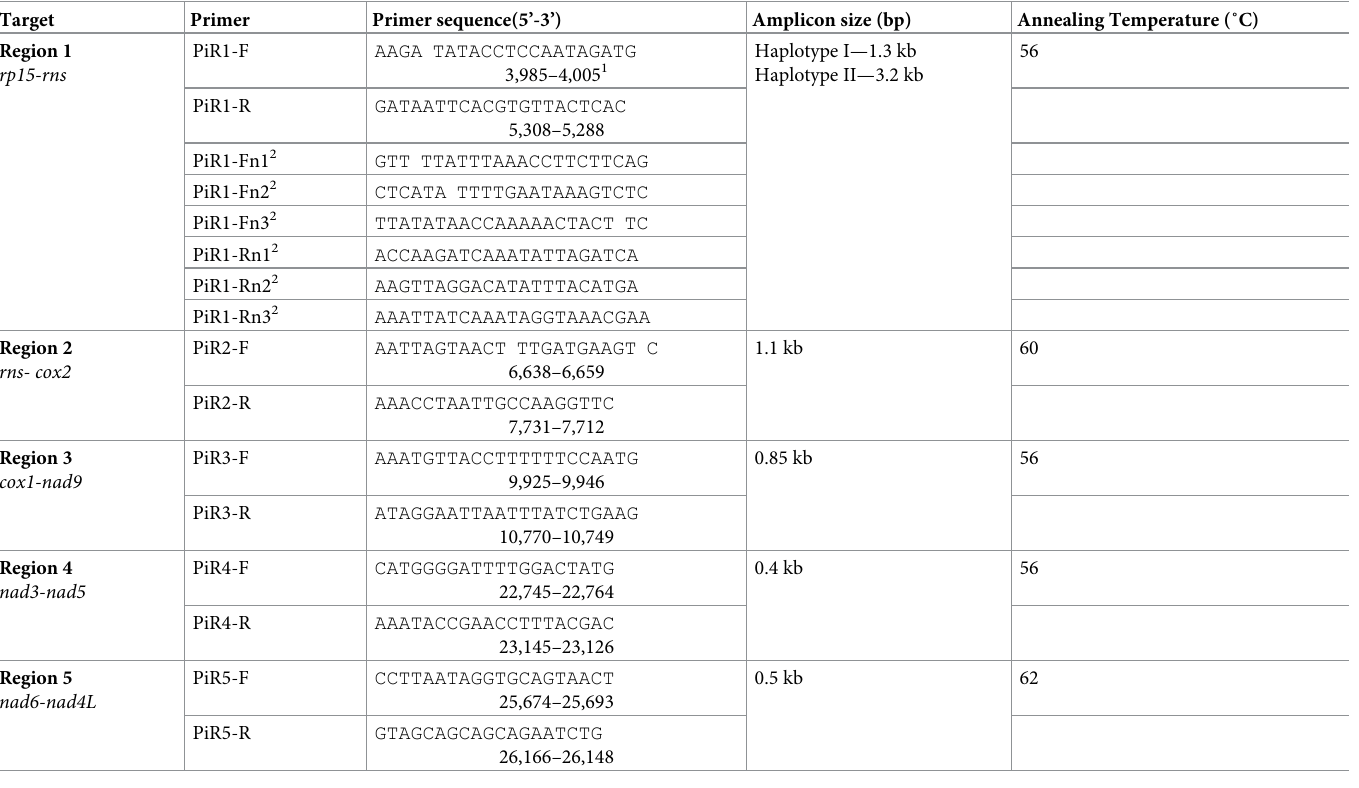
Sequences for each region were aligned by Clustal W in Accelrys Gene v2.5 with McClade v. 4.02 (Sinaur Associates, Sunderland, MA) used to fine tune the alignment. Polymorphisms in the alignments among the isolates for each individual region were checked back against the trace files to ensure accurate base calling and classification as a separate haplotype. Once the analysis of the individual loci was completed and numerical classification of individual haplo- types done, the results for all 5 loci were combined and a numeral designation for each final multilocus haplotype was given (S1 Table). To obtain the final haplotype classification the indi- vidual alignments were concatenated into a single alignment file and analyzed using DnaSP 5.10.01 [49]. Table 1. Primers used for DNA amplification and sequencing of mitochondrial loci. Target Primer Primer sequence(5’-3’) Amplicon size (bp) Annealing Temperature (˚C) Region 1 rp15-rns